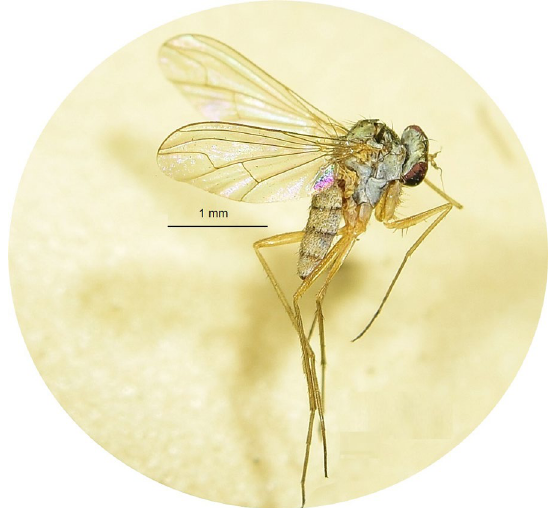
Fig. 9 Sciapus adumbratus (Becker) female habitus,